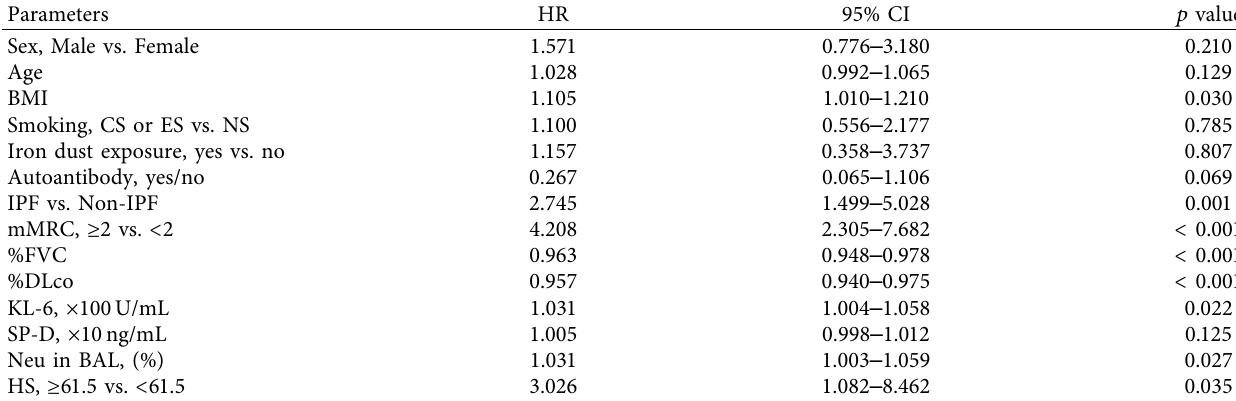
Table 2: Predictors of AE in IIPs (univariate Cox proportional hazard regression analysis).